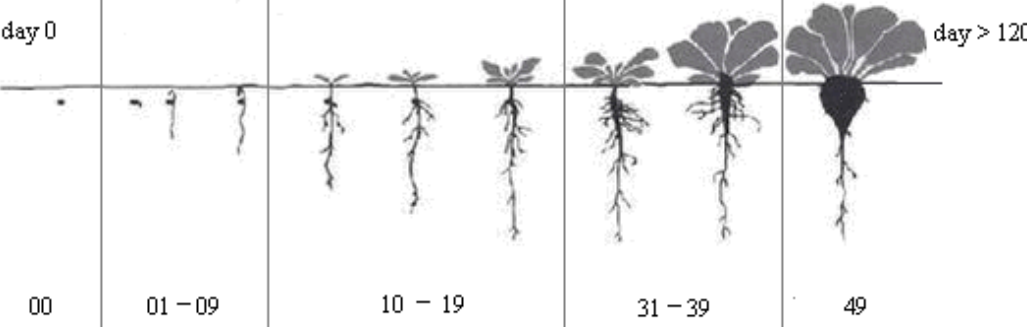
Figure 1. Phenological development of sugar beet plants is shown by using BBCH codes as follows: 00 sowing (dry seed), 01–09 germination, 10–19 leaf development, 31–39 rosette growth, and 49–development of harvestable vegetative plant parts (root), Meier et al., (1993). The most common pests that attack sugar beet in the early stages of leaf development or the youth stage (BBCH 10–19) and cause major damage are wireworms (Agriotes spp., Coleoptera: Elateridae), which live in the soil and feed on roots. The main damage occurs in spring and is manifested by thinning of the crop stand and reduction in yield [7]. Flea